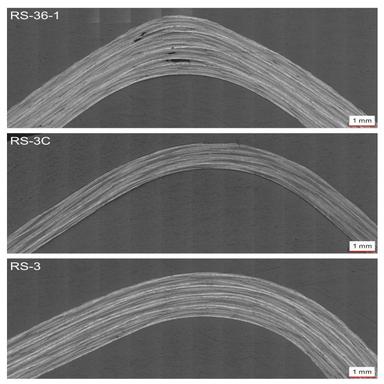
Micrographs of the L-shape laminates at the corner locations for RS-36-1 (top), RS-3C (centre), and and RS-3 (bottom).